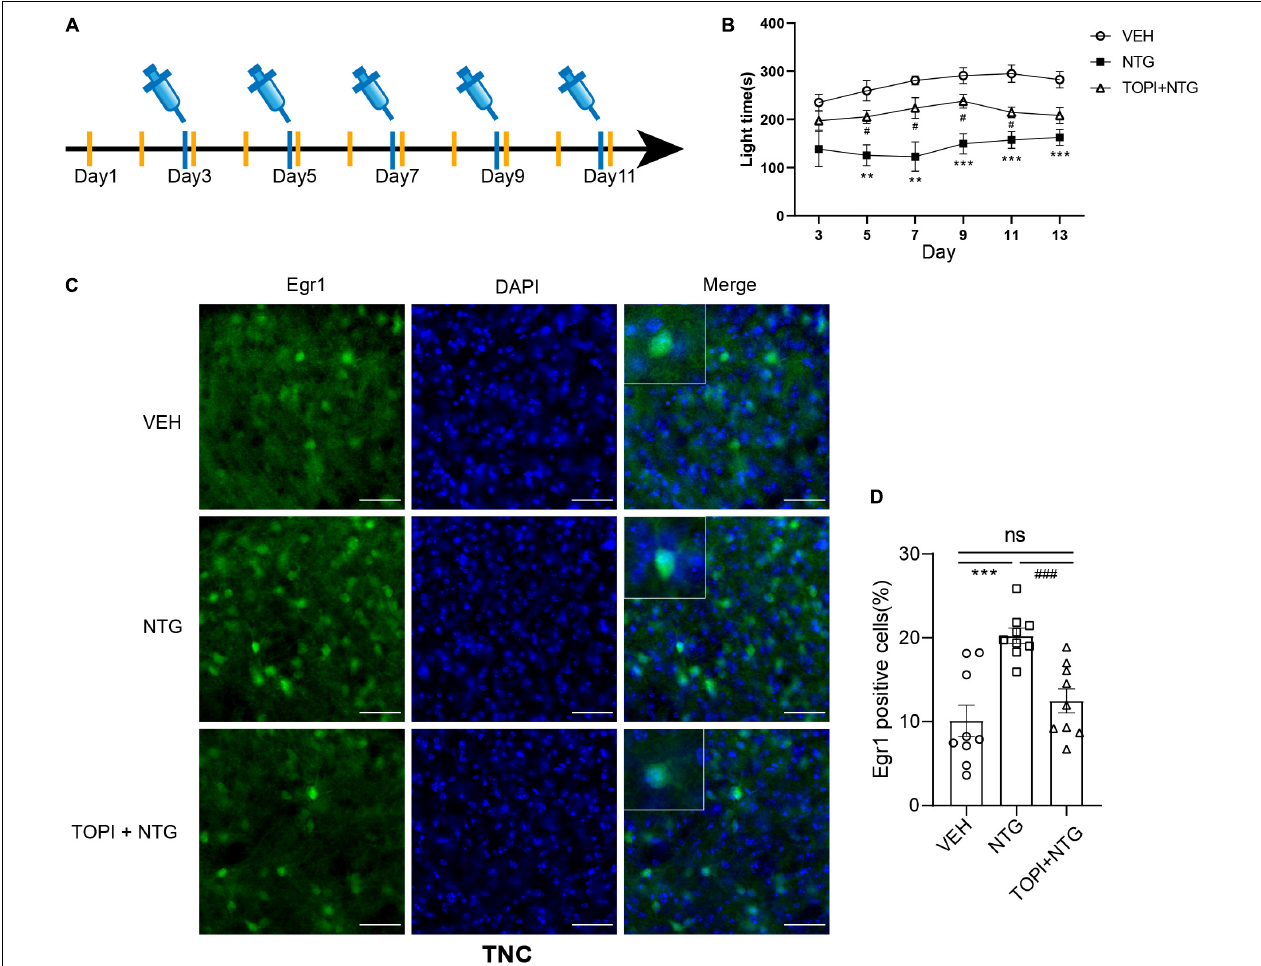
FIGURE 5 | Topiramate improved the photophobia behavior of CM mice and reversed the up-regulation of Egr1 in TNC induced by NTG. (A) Drug administration schedule in topiramate experiment. The yellow vertical line represents the time points of topiramate injection. (B) Topiramate could partially improve the photophobia behavior of CM mice in the short-term. Two-way ANOVA followed by post-hoc Sidak’s multiple comparison test. (C,D) The increased number of Egr1 positive cells in TNC after CM could be reversed by topiramate. Student’s t -test. n = 8/group for behavior test and n = 3/group for the immunofluorescence. ** p < 0.01, *** p < 0.001 compared with vehicle. # p < 0.05, ### p < 0.001 compared with NTG. Scale bars = 50 µ m. Egr1, early growth response protein 1; TNC, trigeminal nucleus